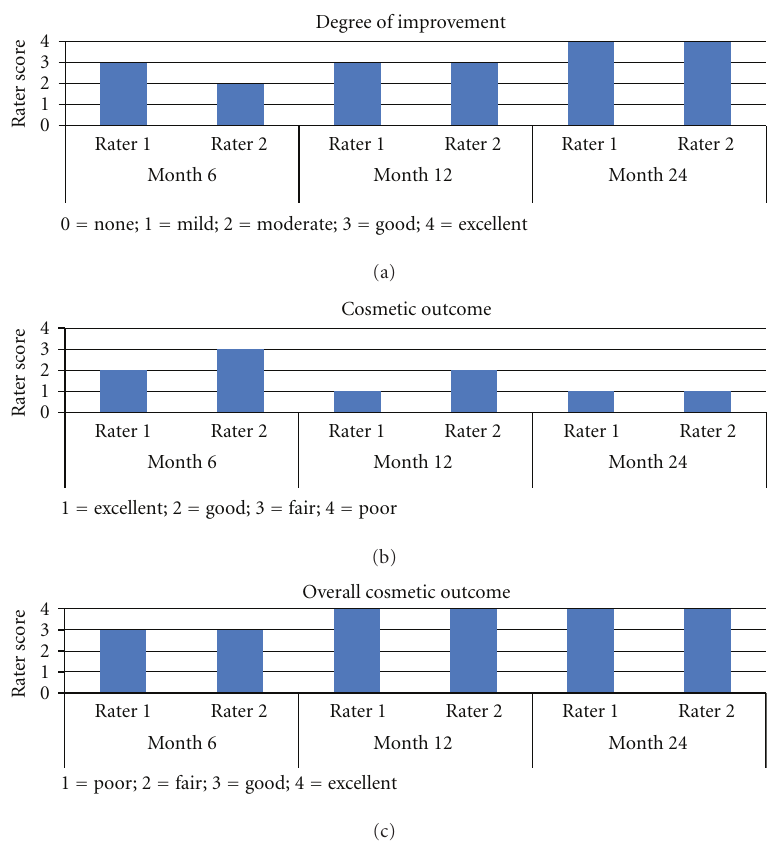
Figure 2: Results from the clinical assessments by two blinded physicians for (a) the degree of improvement from baseline, (b) the c osmetic outcome , and (c) overall cosmetic outcome at Month 6, 12, and 24.